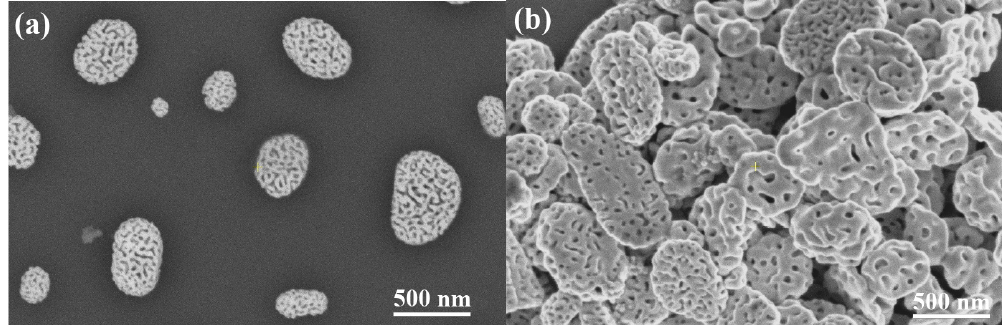
Figure 1. ( a ) SEM images of porous gold nanoparticles (PGNs) prepared by the dewetting-dealloying method on Si/SiO 2 substrate. ( b ) SEM images of support-free PGNs chemically detached from